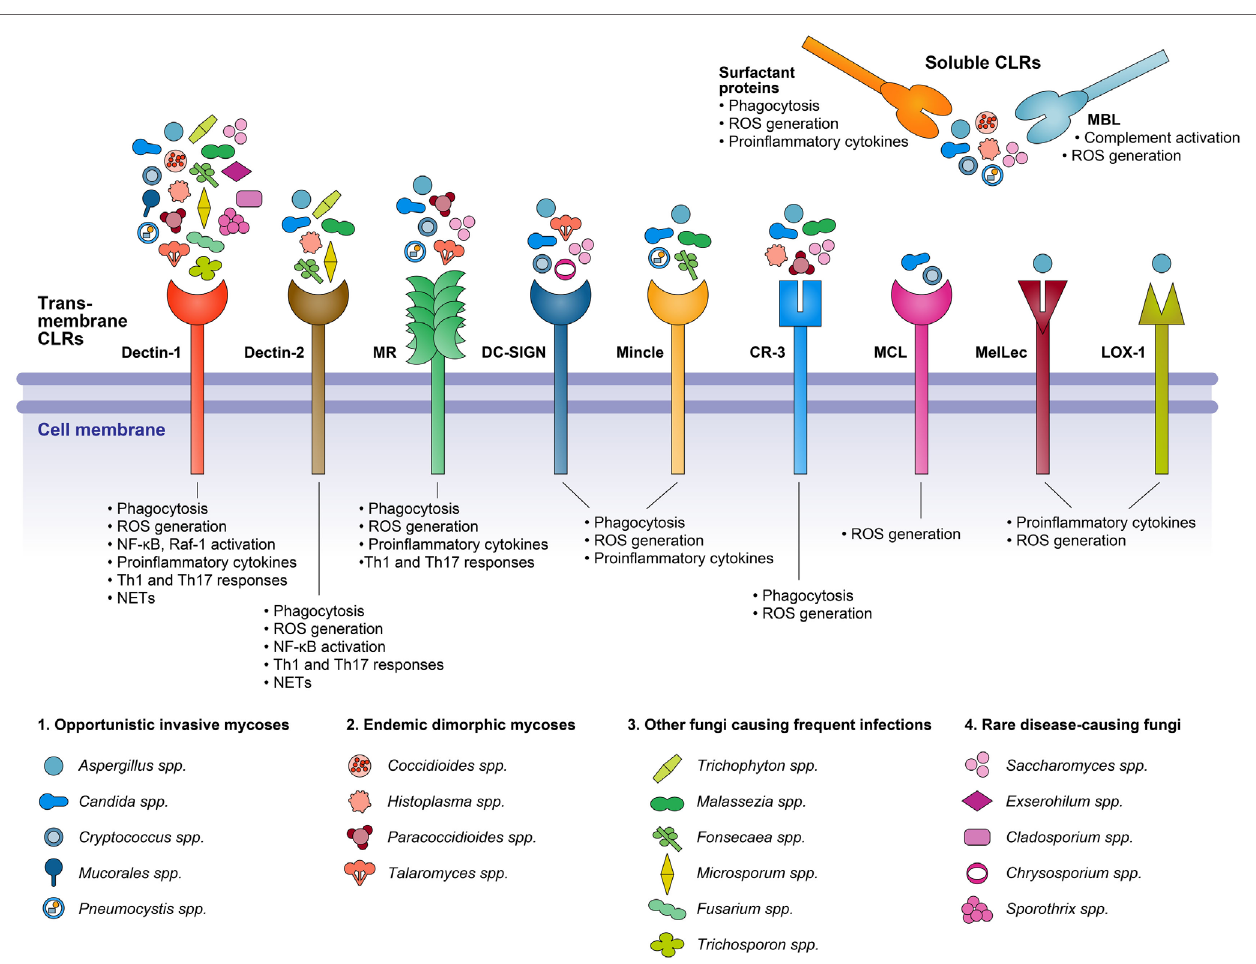
FiGURe 1 | A diagrammatic representation of C-type lectin receptors (CLRs) involved in the recognition of various fungal species, and the resepective cellular responses triggered on receptor–ligand